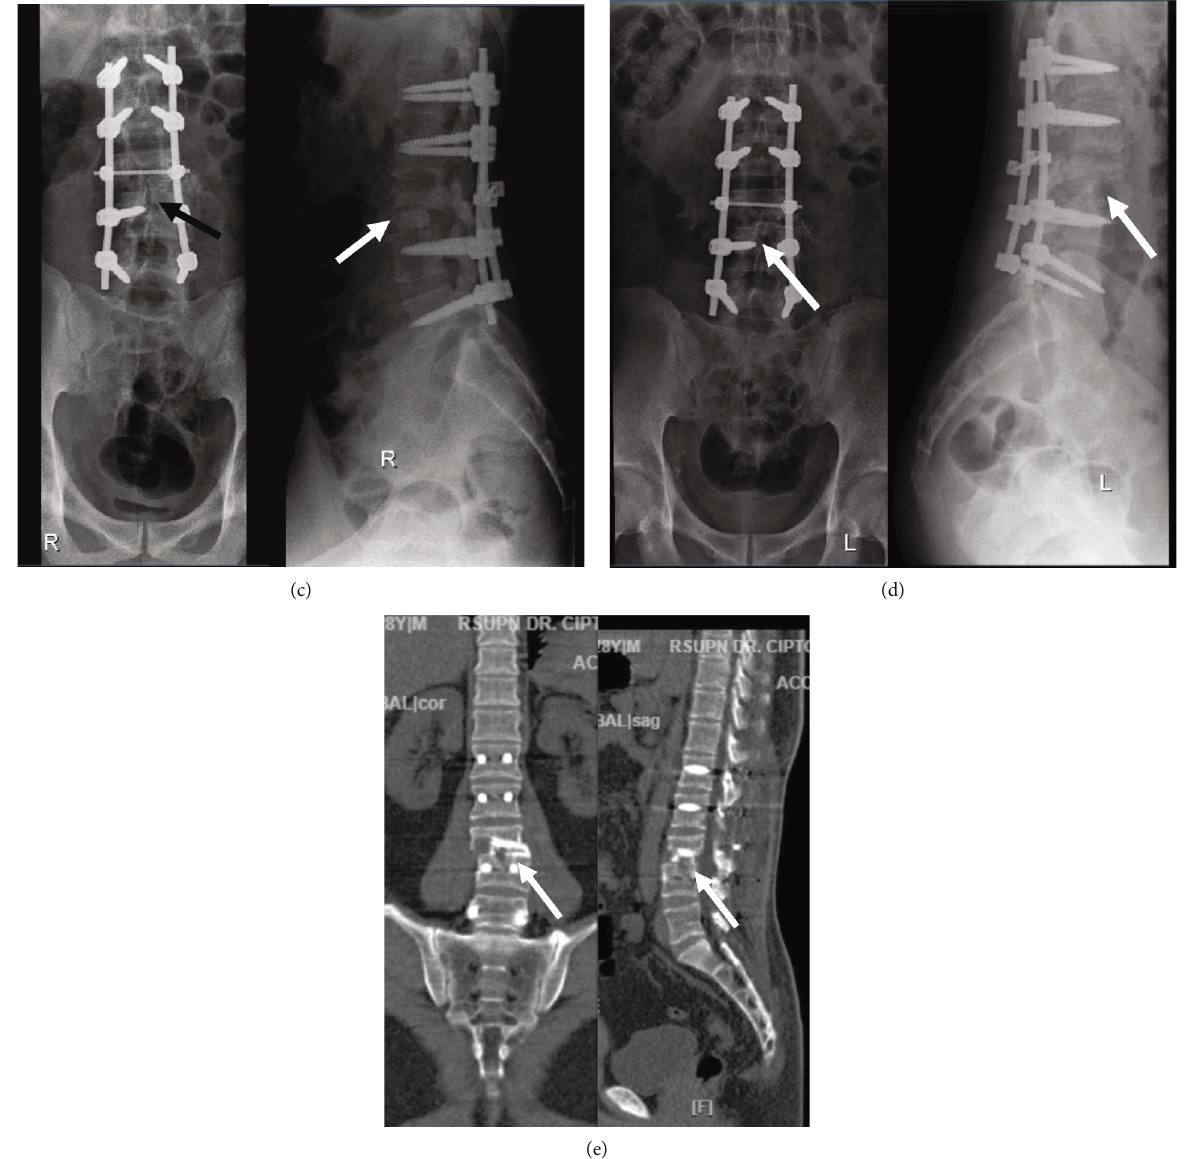
Figure 5: A 27-year-old male (case 2). (a) Preoperative clinical picture showed hyperlordosis. (b) Preoperative radiography showed defect on the anterior column around 55% of the corpus vertebrae. (c) One-month postoperative radiography showed new bone formation that fi lled around 35% of the corpus vertebrae. (d) Three-month postoperative radiography showed new bone formation that fi lled around 60% of the corpus vertebrae. (e) Six-month postoperative CT scan showed 60% of new bone formation on the left posterior lateral of the corpus vertebrae. Sites are shown using white and black